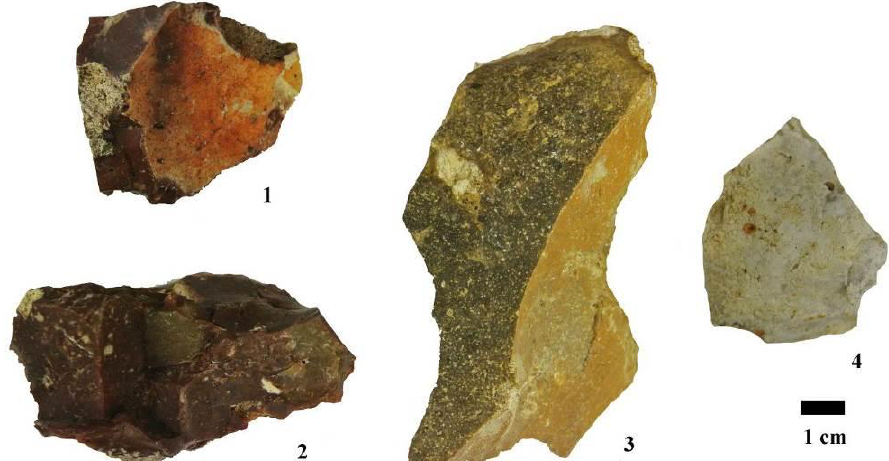
Figure 13. Pieces with alterations: Burnt (1, 2), double patina (3) and white patina (1,